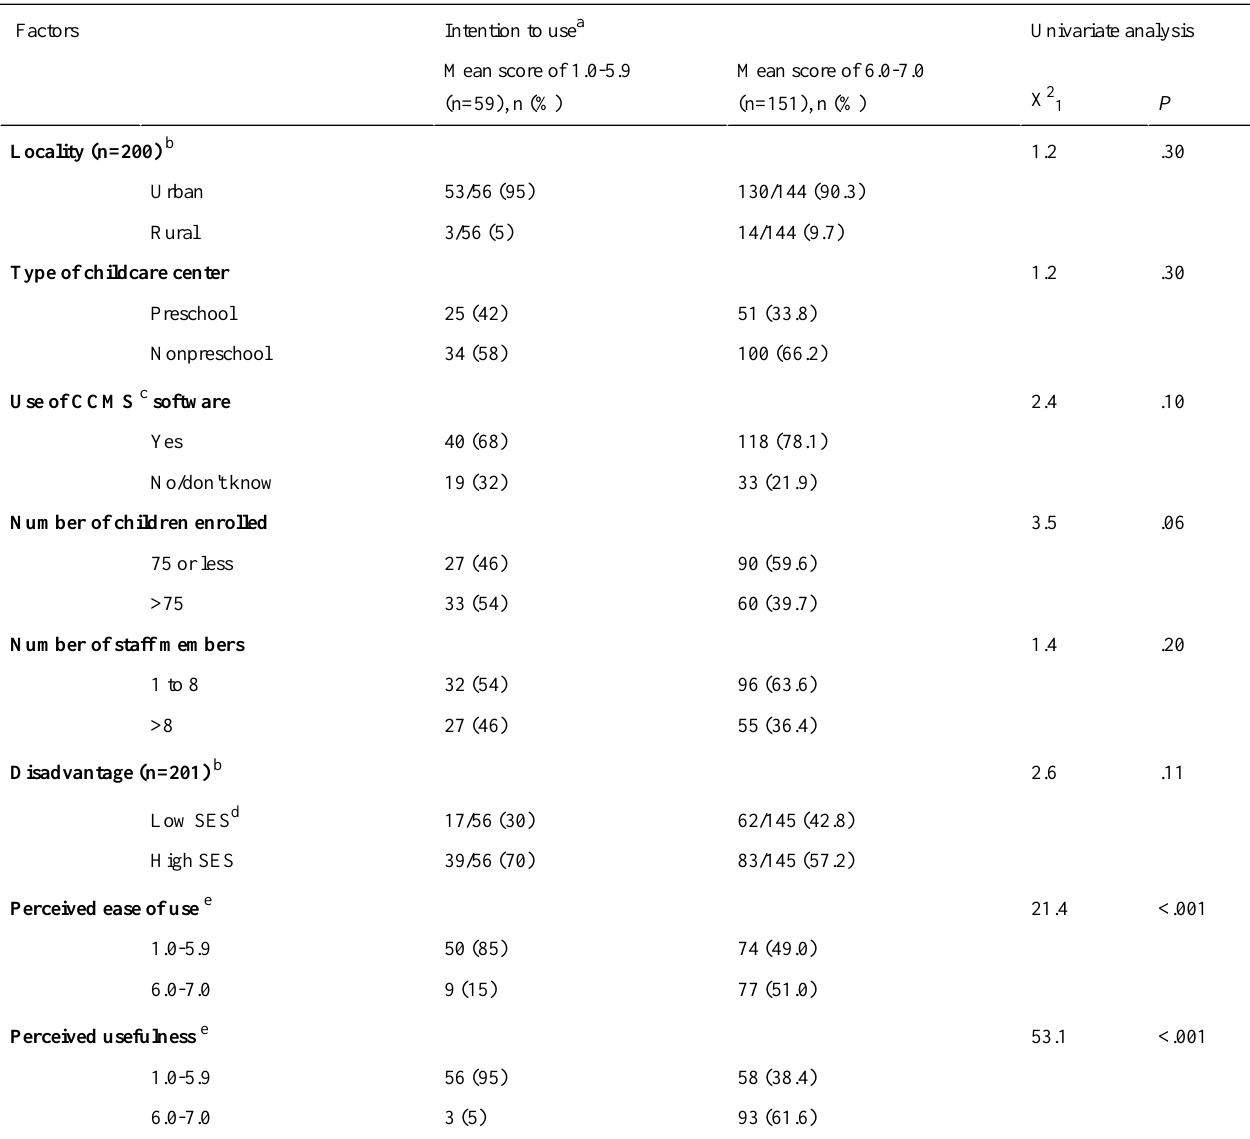
Table 3. Factors associated with intention to use a Web-based program to support staff with implementing healthy eating and physical activity policies and practices